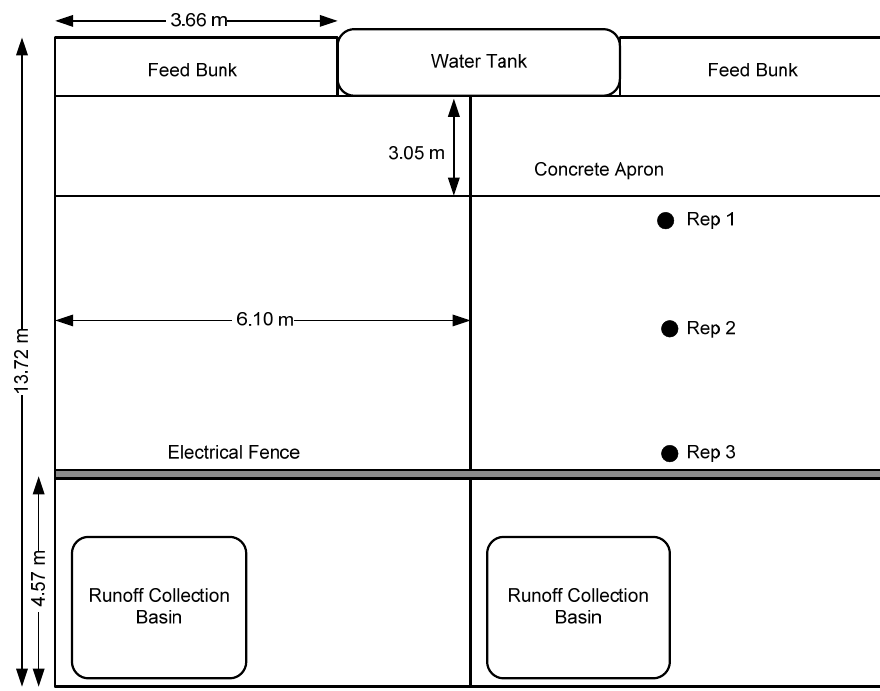
Figure 1. Pen design for the feeding trial and pen surface sampling scheme. Samples were collected from next to the concrete apron, the middle of the pen, and next to an electrical fence that kept cattle out of a collection